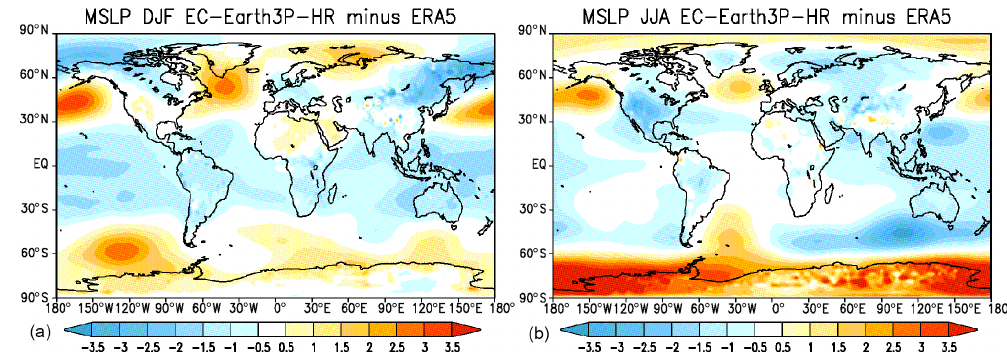
Figure 7. MSLP: bias (hPa) of EC-Earth3P-HR with respect to ERA5 for the period 1979–2014: (a) DJF and (b) JJA. Global means of MSLP for EC-Earth3P-HR are 1011.3 (DJF) and 1009.4 (JJA), and for ERA5 1011.53 (DJF) and 1011.24 (JJA). RMSEs of EC-Earth3P-HR with respect to ERA5 are 1.11 (DJF) and 1.27